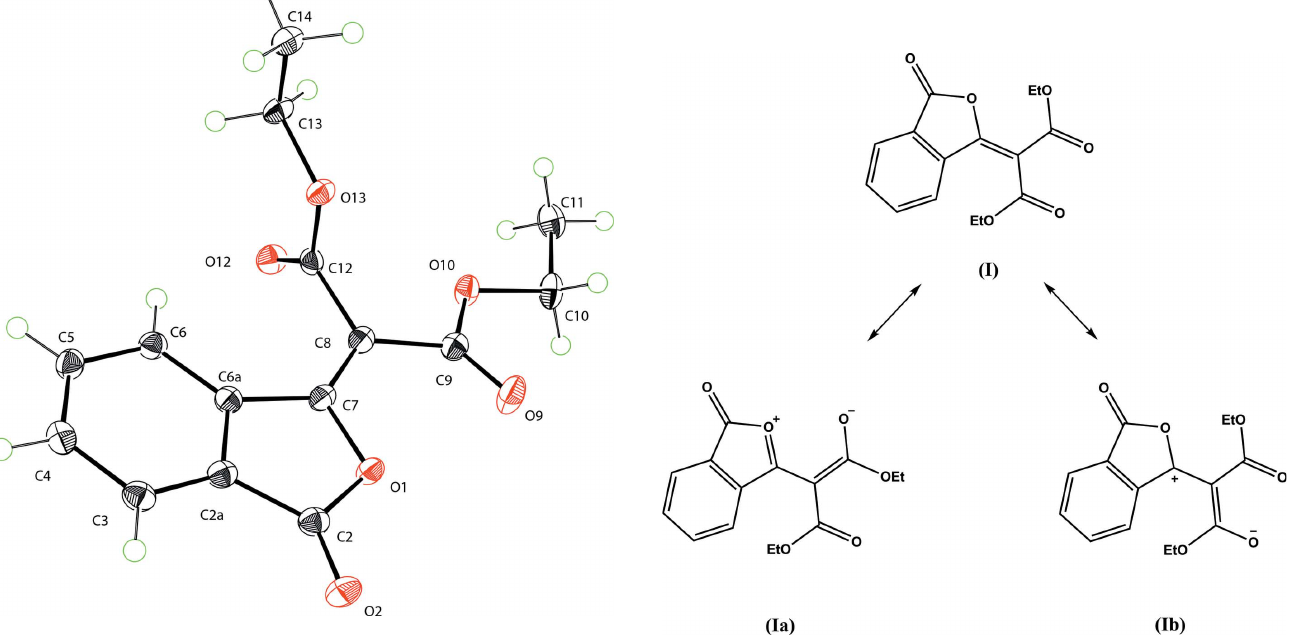
Figure 2 Chemical diagram of a molecule ( I ) and its possible resonance forms ( Ia ) and ( Ib ).